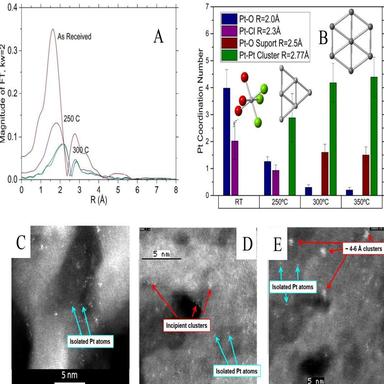
Pt on γ-Al2O3 after low temperature reduction from as received (AR) to 350 °C. Magnitude of the Fourier transform EXAFS spectra (A) and EXAFS results for coordination numbers and representative models (B). AC-STEM images as received (C) and after 250 °C reduction (D) and after 350 °C reduction (E).